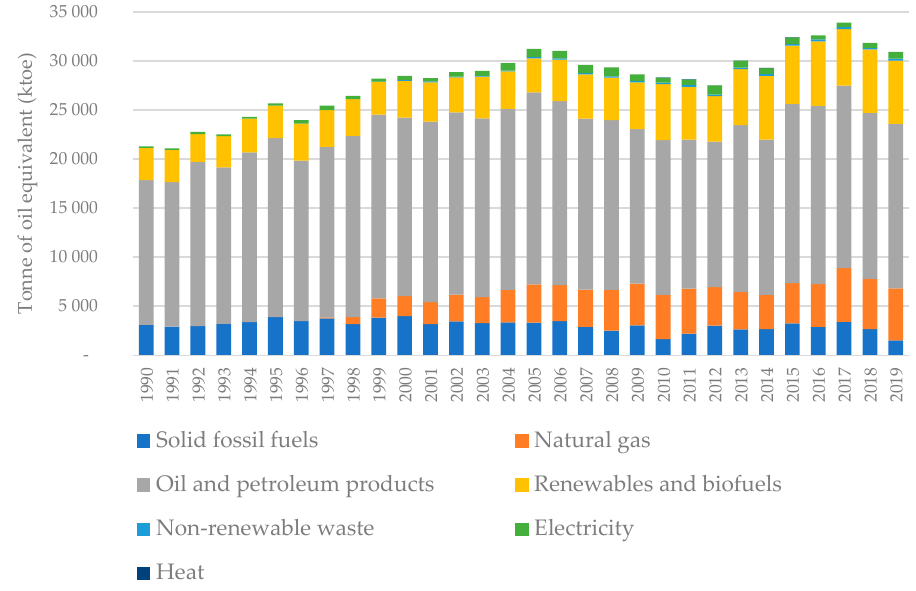
Figure 10. Portuguese energy mix available from all sources in ktoe (adopted from Eurostat data). With a focus on 2019 (Figure 11), the endogenous energy sources used are practically 100% from renewables (including biofuels), representing around 21% of the global Portuguese energy mix.